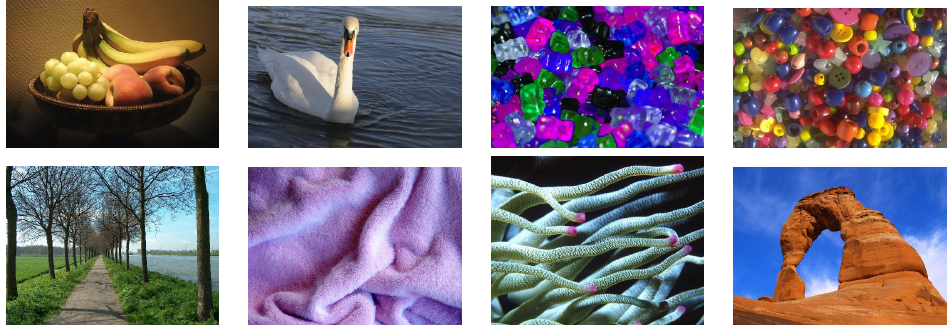
Figure 4. Images examples from the SENSE database